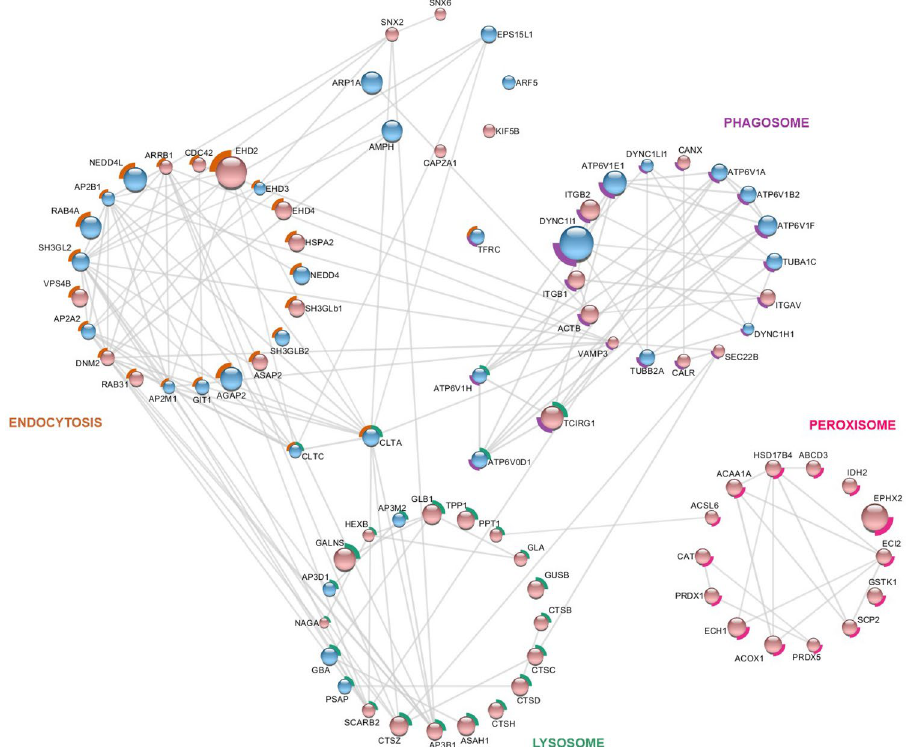
Figure 6. Network analysis of differently abundant proteins annotated to cellular process pathways according KEGG pathway database. Using StringApp, a Cytoscape app, functional enrichment analyzes were retrieved from the whole STRING network of cellular processes entries classified according to BlastKOALA. A subset of networks resulted from the enriched terms endocytosis (orange contour), lysosome (green contour), peroxisome (pink contour) and phagosome (purple contour). Node colors indicate increased abundant proteins in female (pale pink) and male (blue) hippocampus and node size indicates different levels of fold change relative to each individual network. For more details, see Supplementary Dataset 2. Statistical analyses were performed by using Student’s t test followed by multiple testing corrections using the Benjamini–Hochberg procedure for false discovery rate (n = 5 biological replicates, each containing 3